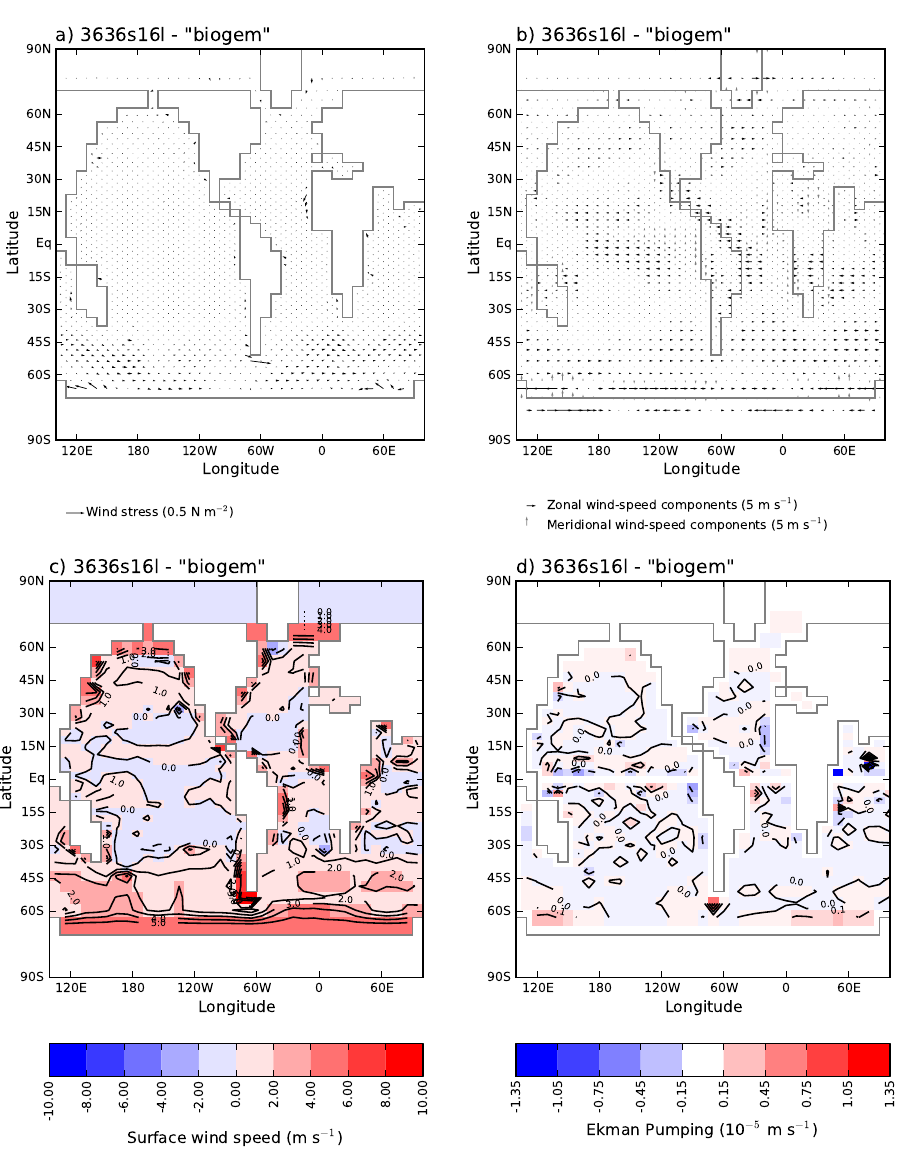
Fig. 4. Difference in wind stress forcing (a) , advective wind transport fields (b) , surface wind speed (c) , and Ekman pumping (d) between the 3636s16l and “biogem” setups. Note, the Ekman pumping was computed on the model grid as the vertical component of 1 /(ρf ) ∇ × (τ zonal ,τ merid. , 0 ) , where f is the latitude-dependent Coriolis parameter, ρ is 1000 m s − 1 and τ zonal and τ merid. are the horizontal zonal and meridional wind stress component fields, respectively, not including the up-scaling of the wind stresses as applied by the ocean model